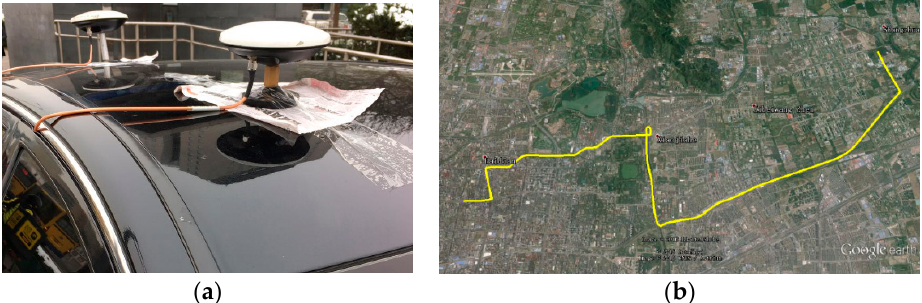
Figure 15. The urban vehicle test condition: ( a ) the location of two antennas; ( b ) the route of the urban vehicle test.